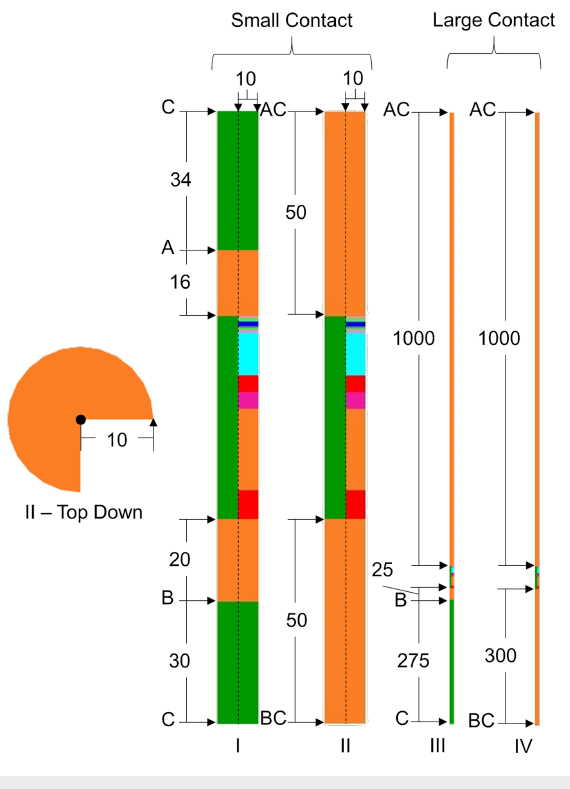
Figure 4: Schematic top-down view and quarter cross-section view of the simulated geometries. The dotted lines indicate the axis of symmetry for the 2D cylindrical simulations. The active area of the device is surrounded by an insulating passivation layer (green). Four contact configurations are considered to model different layers and interconnects in an actual array: small passivation–Cu (I), small Cu (II), large passivation–Cu (III), and large Cu (IV). A thermal boundary resis- tance between the metal and insulating layers (A and B interfaces) is considered in some of the simulations. Key: C = heat sink ( T = 300 K), A = top contact, B = bottom contact, AC = heat sink and top contact, BC = heat sink and bottom contact. All dimensions shown are in units of nanometers. All stack configurations have an active magnetic tunnel junction radius of 10 nm. Different scale factors are used for I, II and III, IV to account for significant differences in device